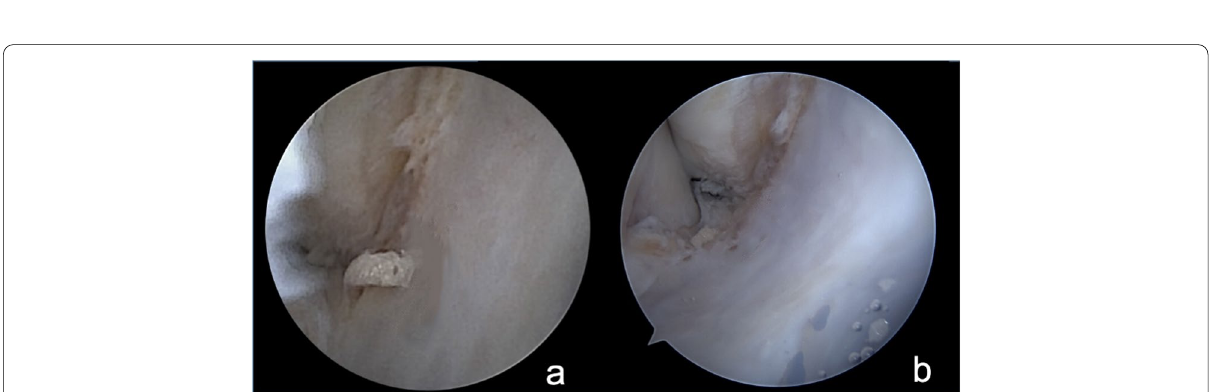
Fig. 5 Placement of the cannula in the lateral gutter. A NanoScopeTM view. B Standard arthroscope view